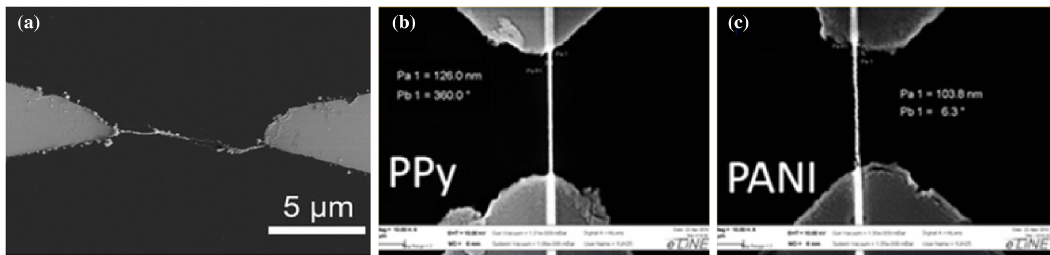
Figure 7. Comparison of resulting electrosynthesized wires: ( a ) PEDOT nanowire grown in between two gold electrodes [52] and ( b , c ) PPy and PANI nanowires grown in a confining PMMA nanochannel [53]. Reprinted from [53], Copyright 2013 and [52], Copyright 2012, with permission from